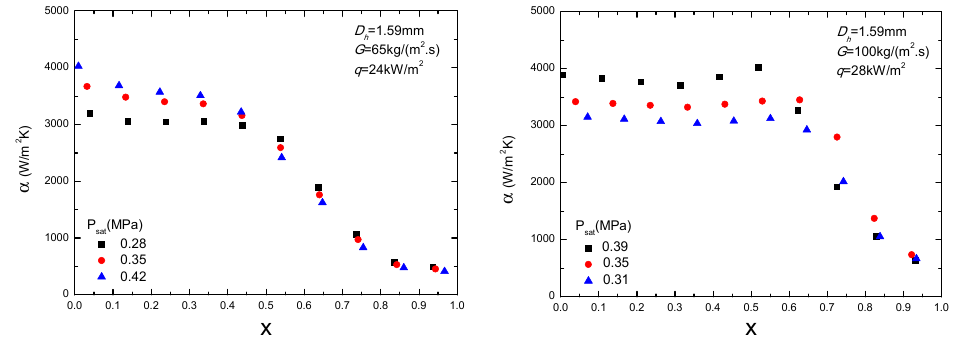
Figure 3. Effect of saturation pressure on heat transfer coefficient.